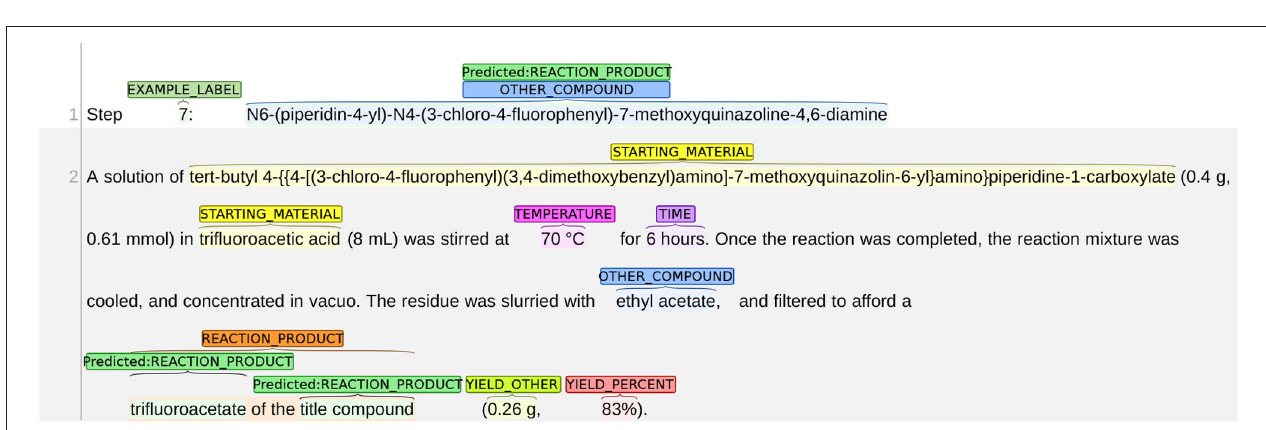
FIGURE 10 | An example of misclassification between REACTION_PRODUCT and